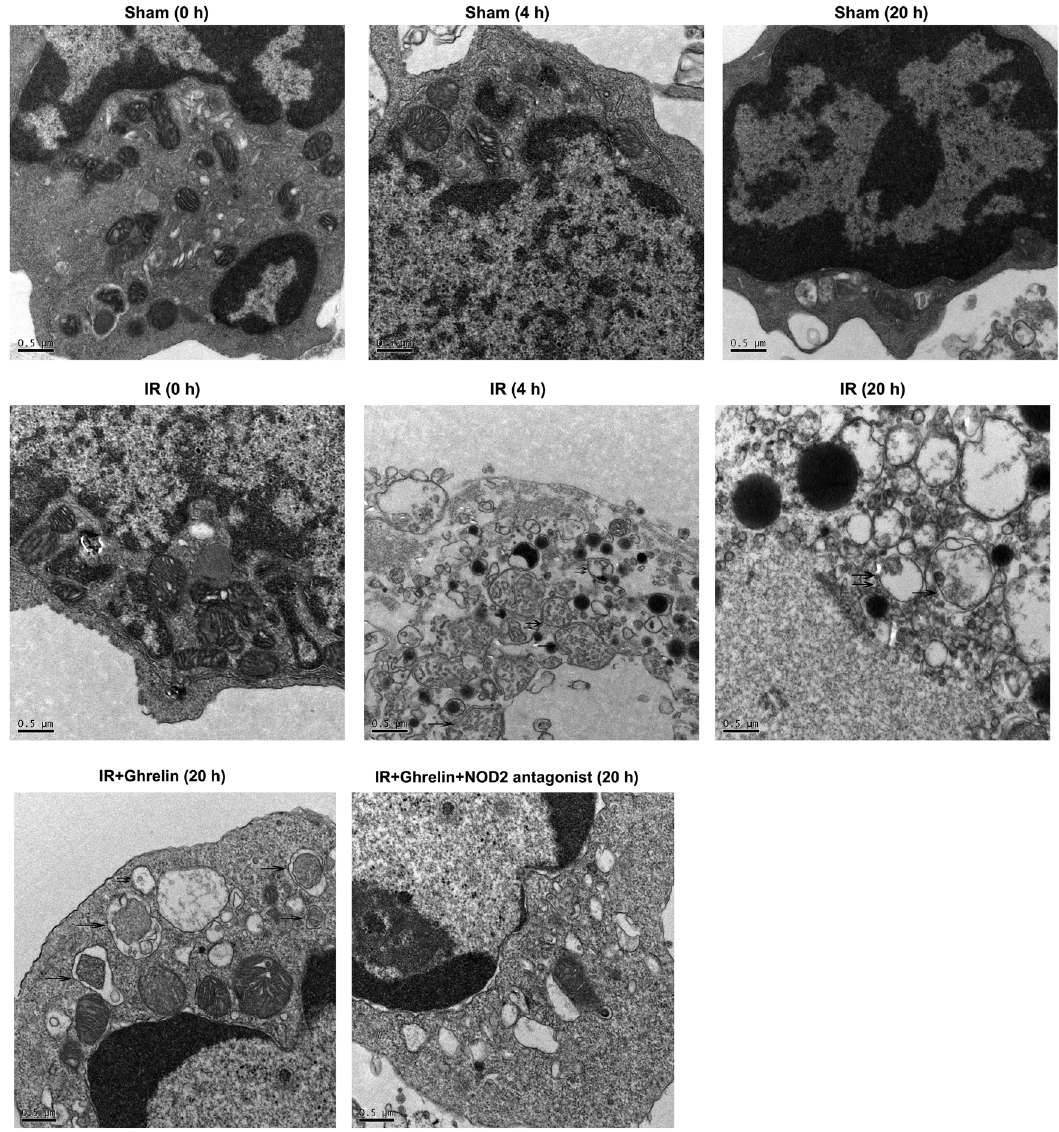
Figure 2: NOD2 antagonist inhibited the phagocytic functions of ghrelin in the intestinal epithelium of rats. Representative electron microscopy images of the intestinal epithelium. Double arrowheads indicated autophagosomes and single arrowheads indicated auto - lysosomes containing organelles. n =